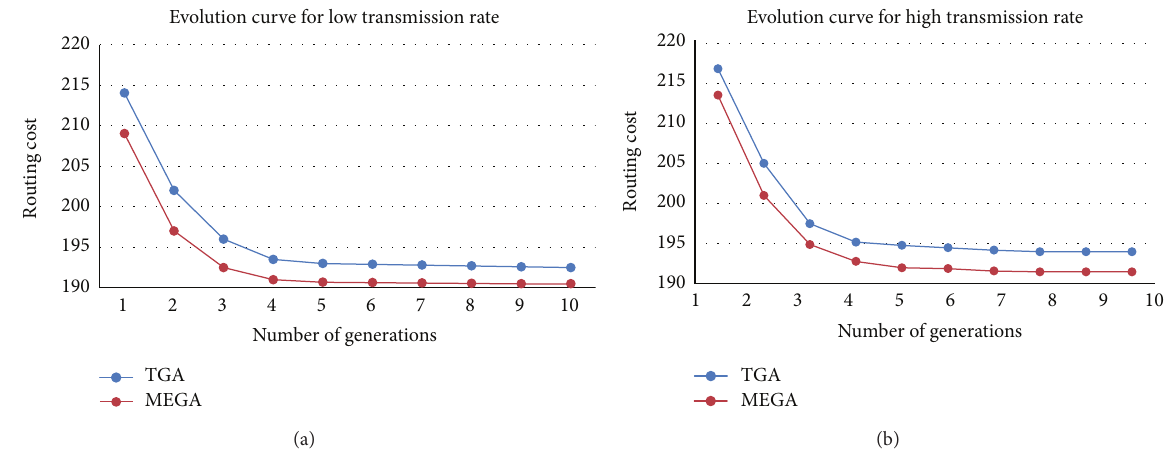
Figure 4: Evolution curves of two different transmission rates (a) 0.25 Mbps and (b) 0.5